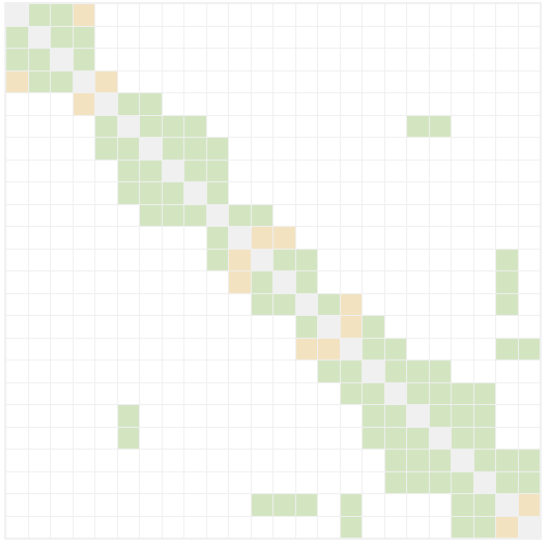
Figure 8. Case Study 1: matrix showing the results of scan pairwise registration using a target-based approach. Average target residuals are displayed using following colours: green < 3.0mm, orange between 3.0 - 10 mm, red > 10.